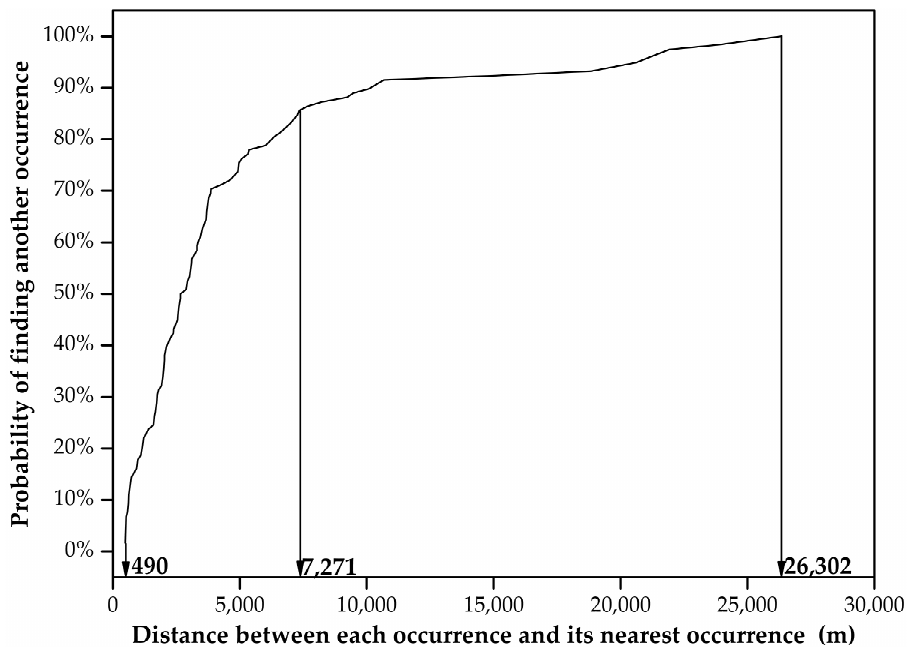
Figure 6. Plot of distances and corresponding probabilities that one W occurrence is situated next to another known W occurrence.